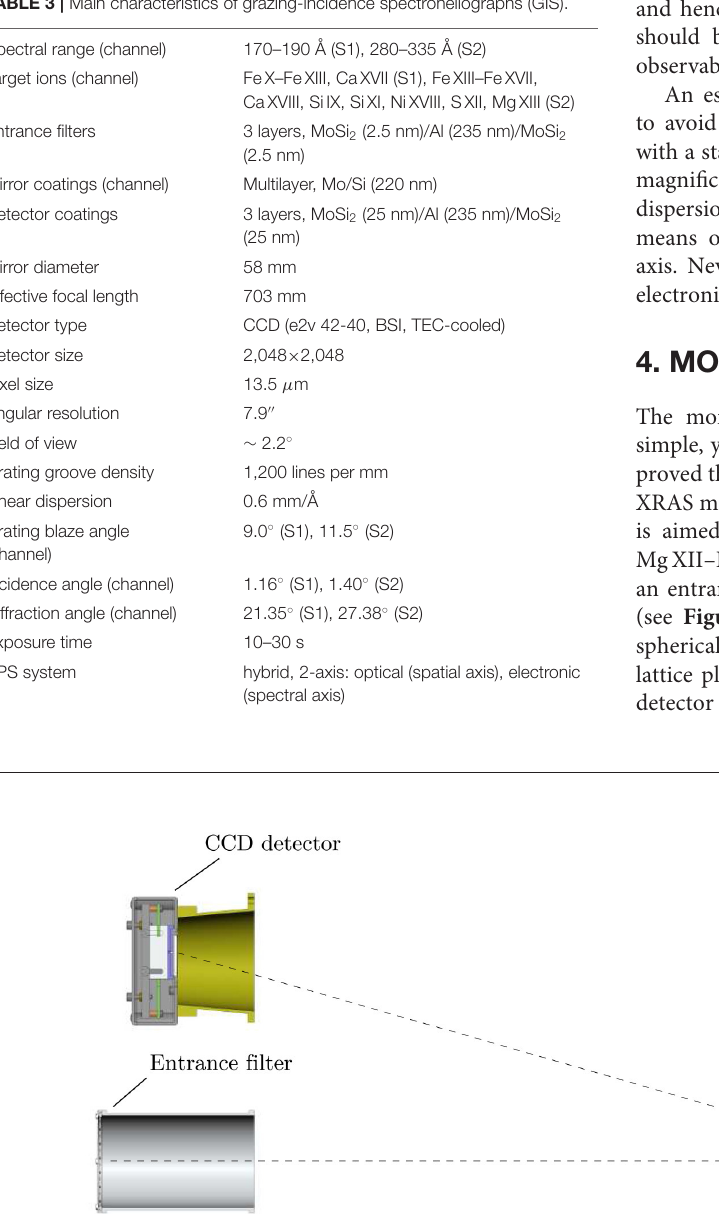
Frontiers in Astronomy and Space Sciences |